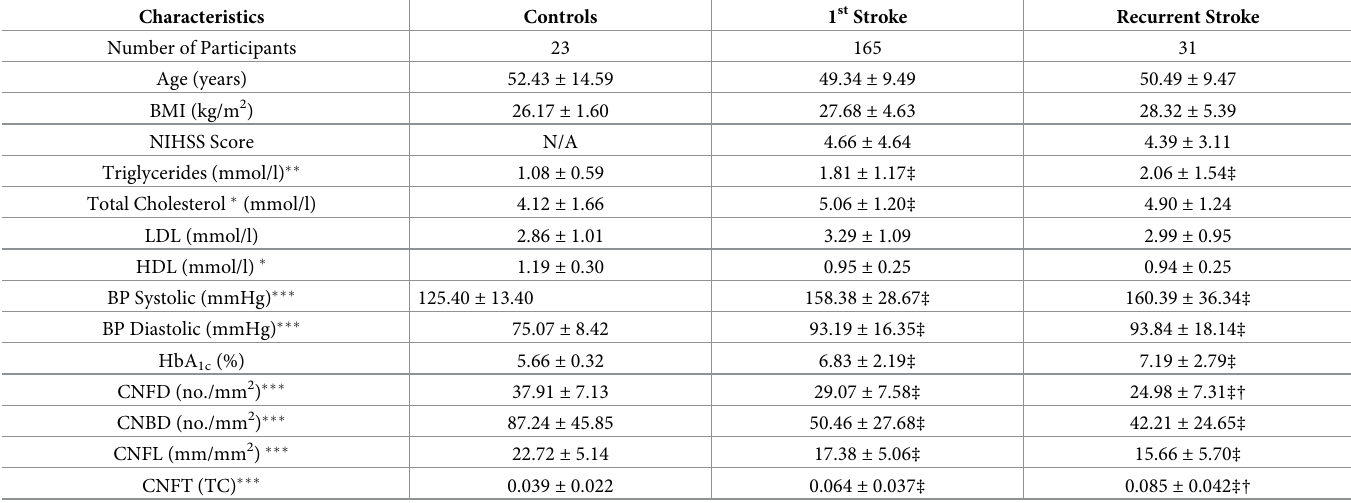
Table 1. Clinical, demographic, metabolic and CCM measures in study participants. Characteristics